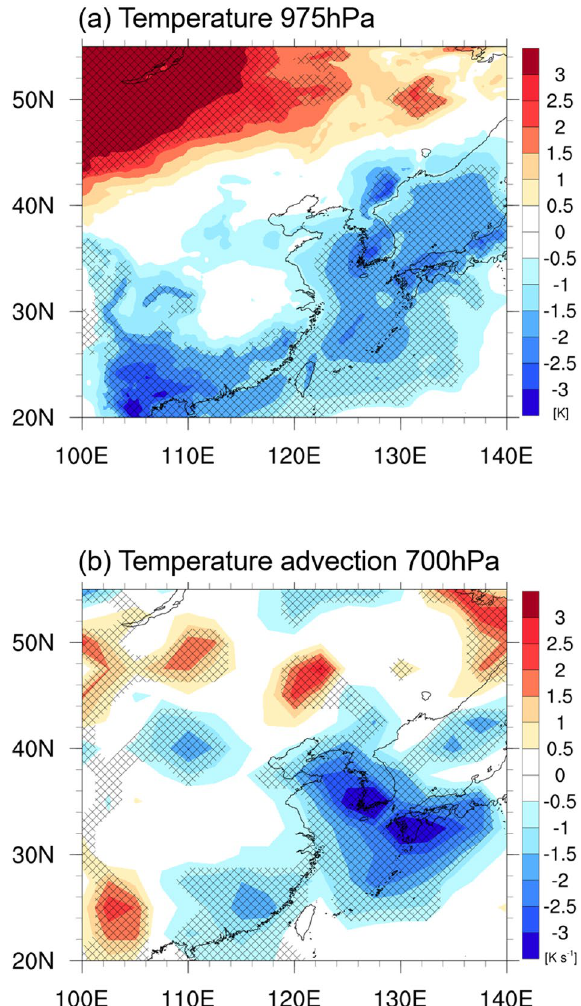
Figure 1. Maps of cold condition in April 2020. Spatial patterns of the ( a ) 975-hPa temperature (shading, K) and ( b ) 700-hPa temperature advection anomalies (shading, 10 −5 K s −1 ) in April 2020 for ERA5. Hatched areas denote the statistically significant regions at the 90% confidence level. The maps were generated using the NCAR Command Language Version 6.4.0 (http:// www. ncl. ucar.